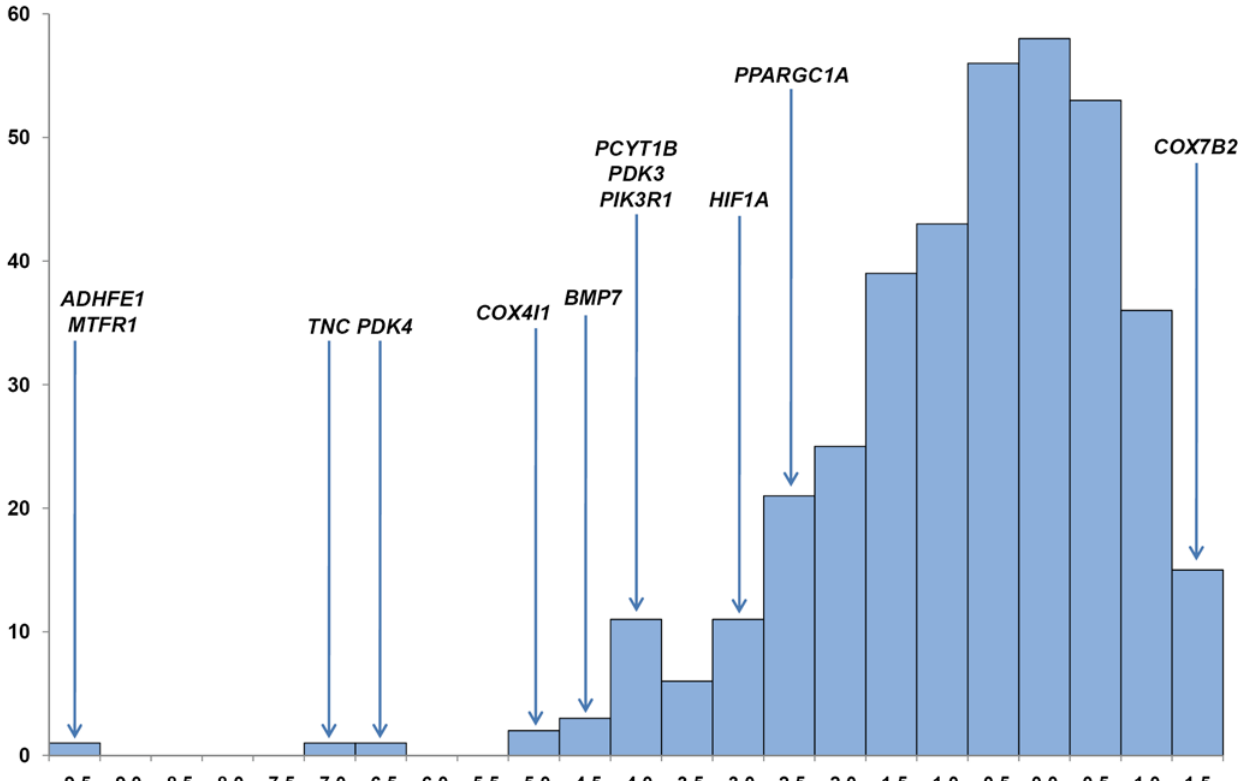
Figure 1. Empirical distribution for Dh/sd. The empirical distribution for Dh/sd scores (horizontal axis) from the Ewens-Watterson test. The vertical axis indicates the number of loci with the corresponding Dh/sd score. The positions in the distribution of the regions that have been subject to selection in Thoroughbred are indicated by the gene symbols for the strongest candidate genes. Genes in the negative tail-end of the distribution may have been subject to positive selection. Genes in the positive end of the distribution may have been subject to balancing selection.